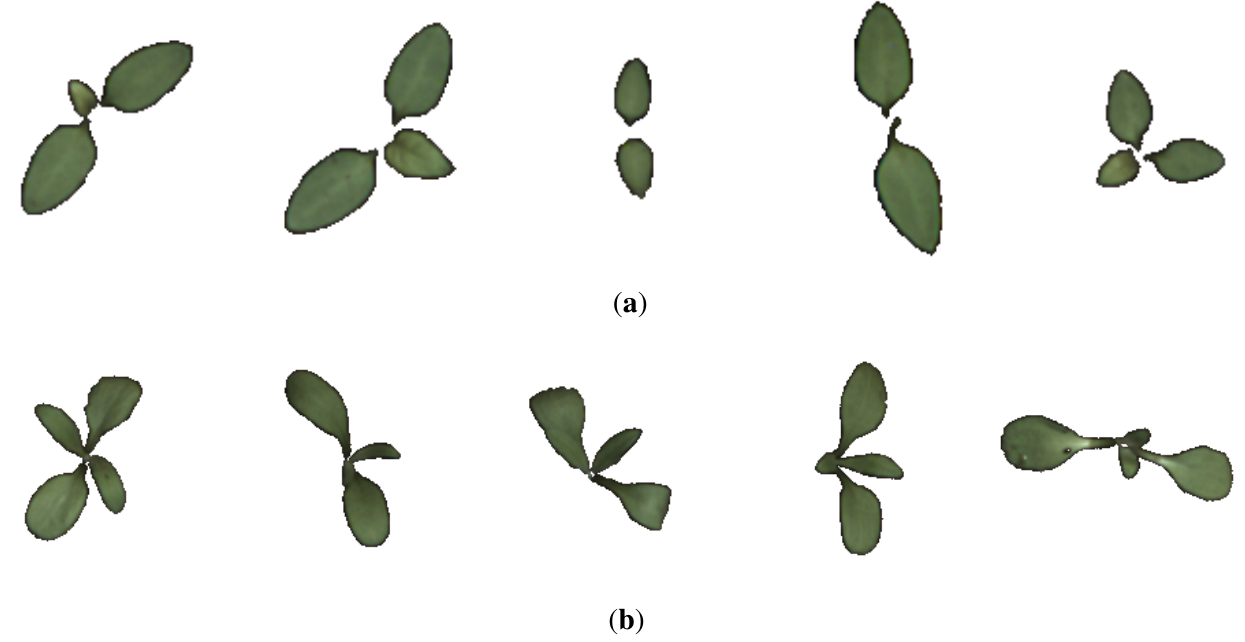
Figure 1. 10 random samples from the image database. ( a ) 5 random nightshade samples from the image database; ( b ) 5 random cornflower samples from the image database.